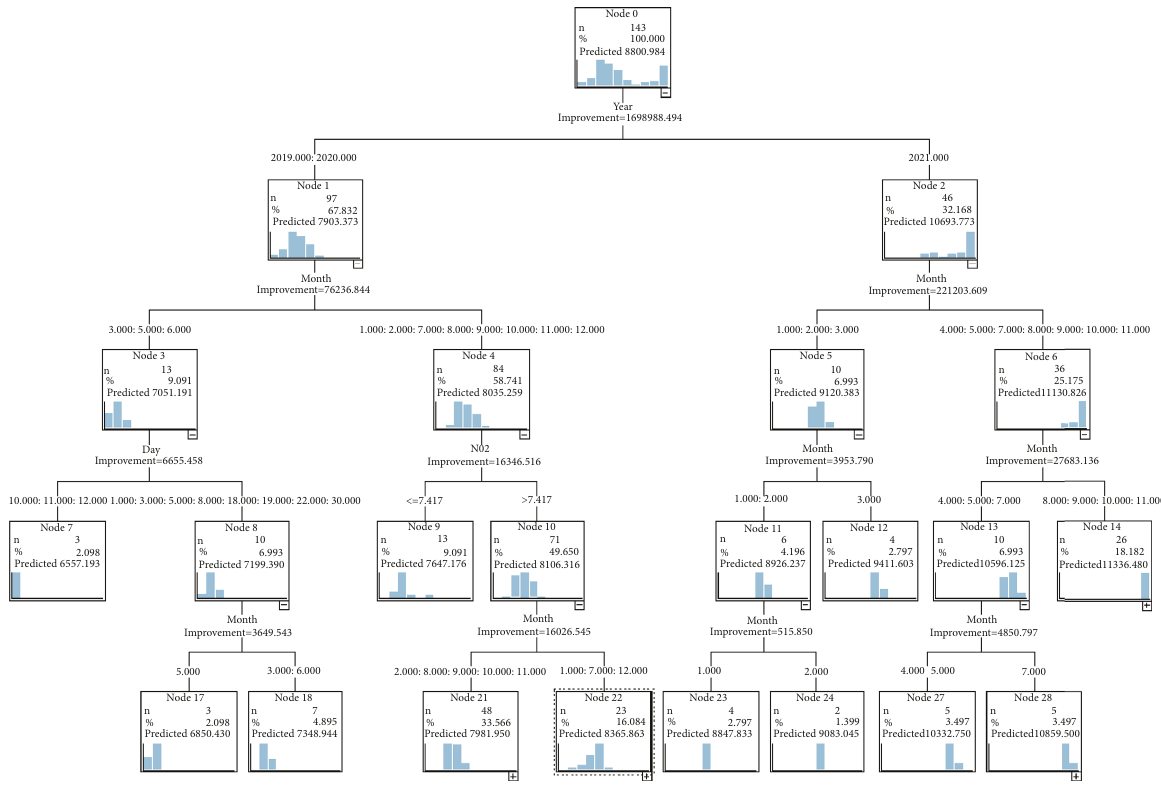
Figure 6: Partial classification tree for TASI CR-Tree predictor.